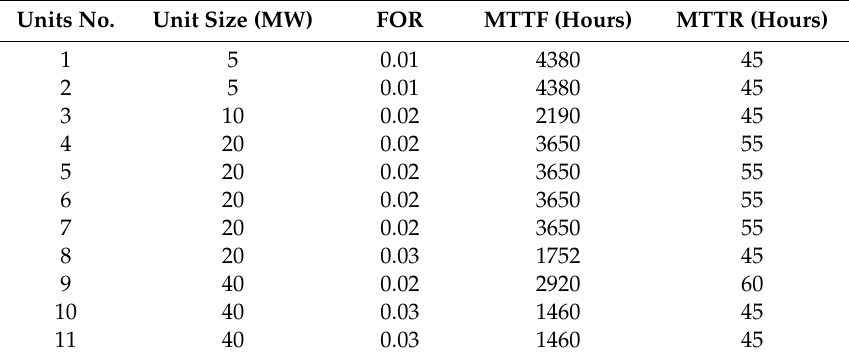
Table A1. The RBTS generating unit ratings and reliability data. Units